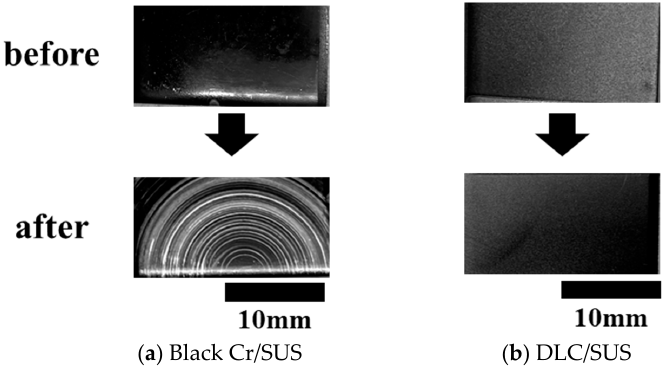
Figure 7. Surface image of ( a ) Black Cr/SUS and ( b ) DLC/SUS after cleaning test. Table 5. Glossiness of samples before and after the cleaning test.